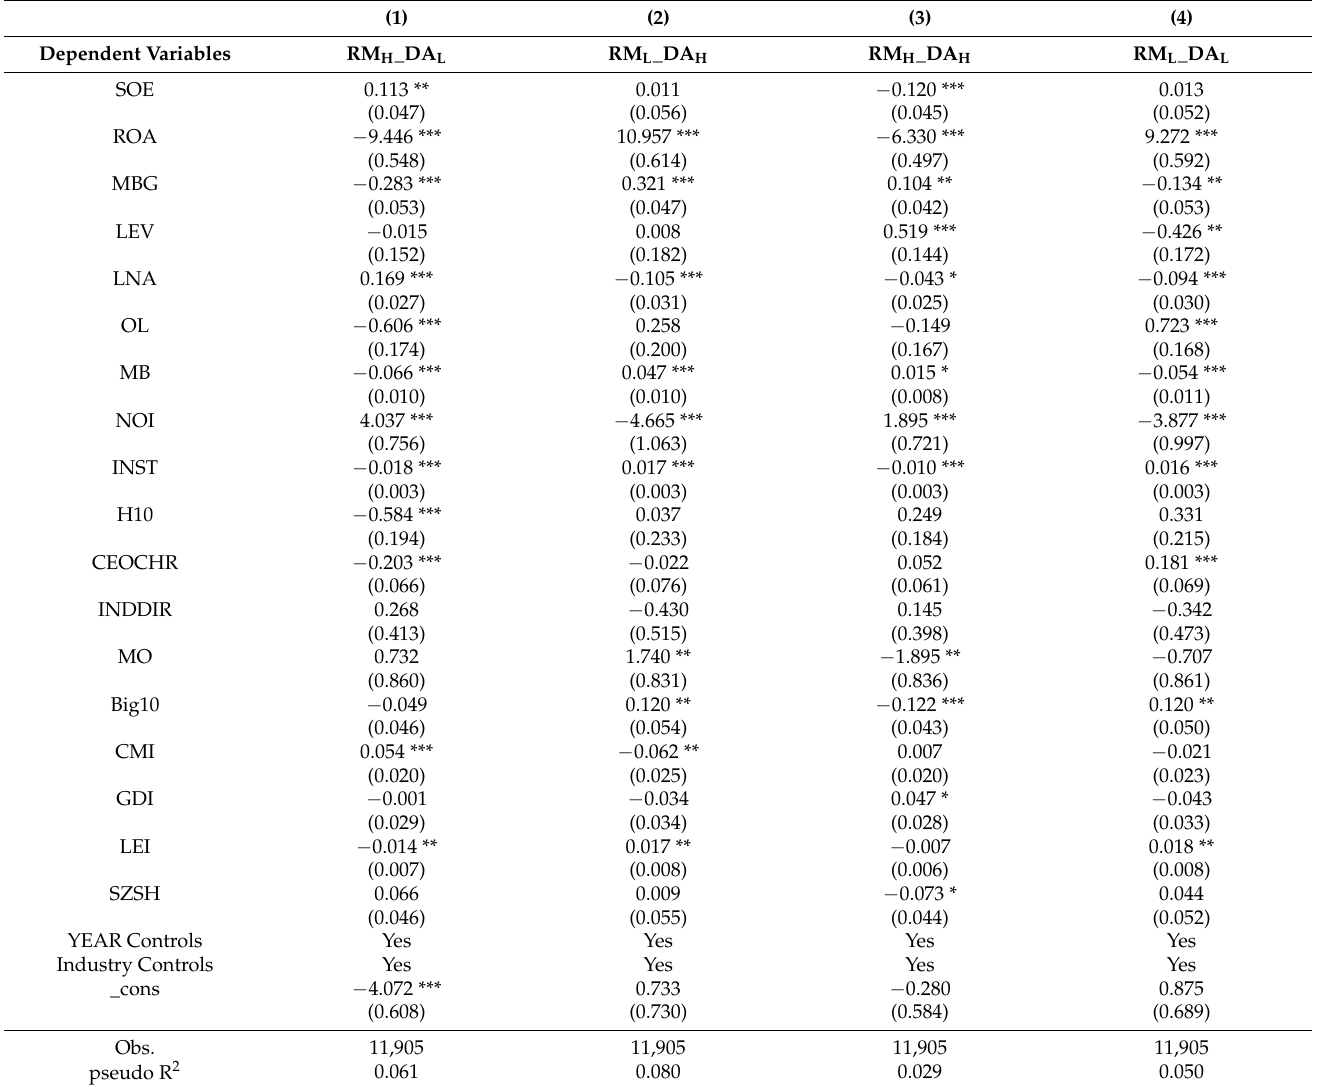
Table 6. The Effect of State Ownership on Earnings Management Combination